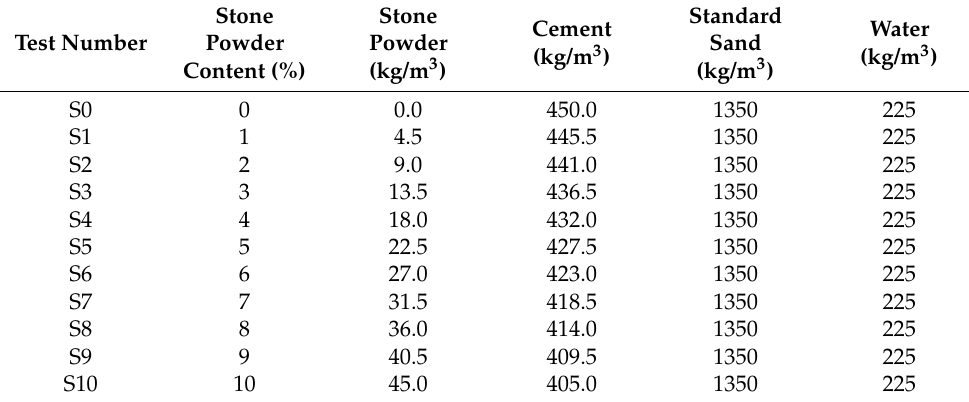
Table 2. Test of mortar strength of standard sand.